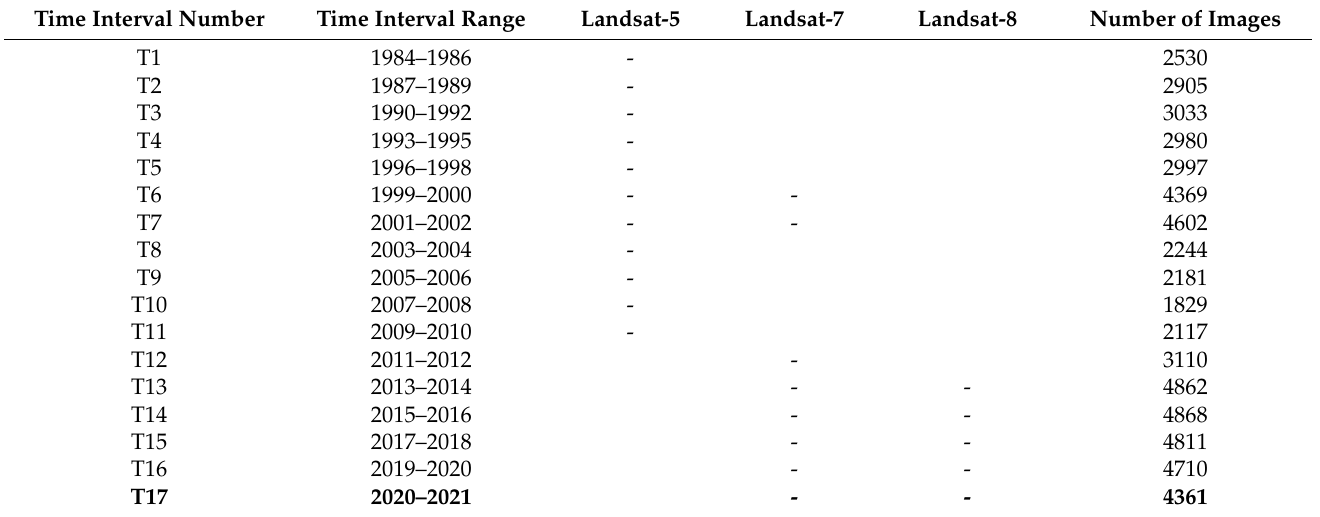
Table 2. The Landsat images used at different time intervals (i.e., two or three years) to pro- duce 17 wetland maps. (The time interval which is bolded was used as the reference interval for change